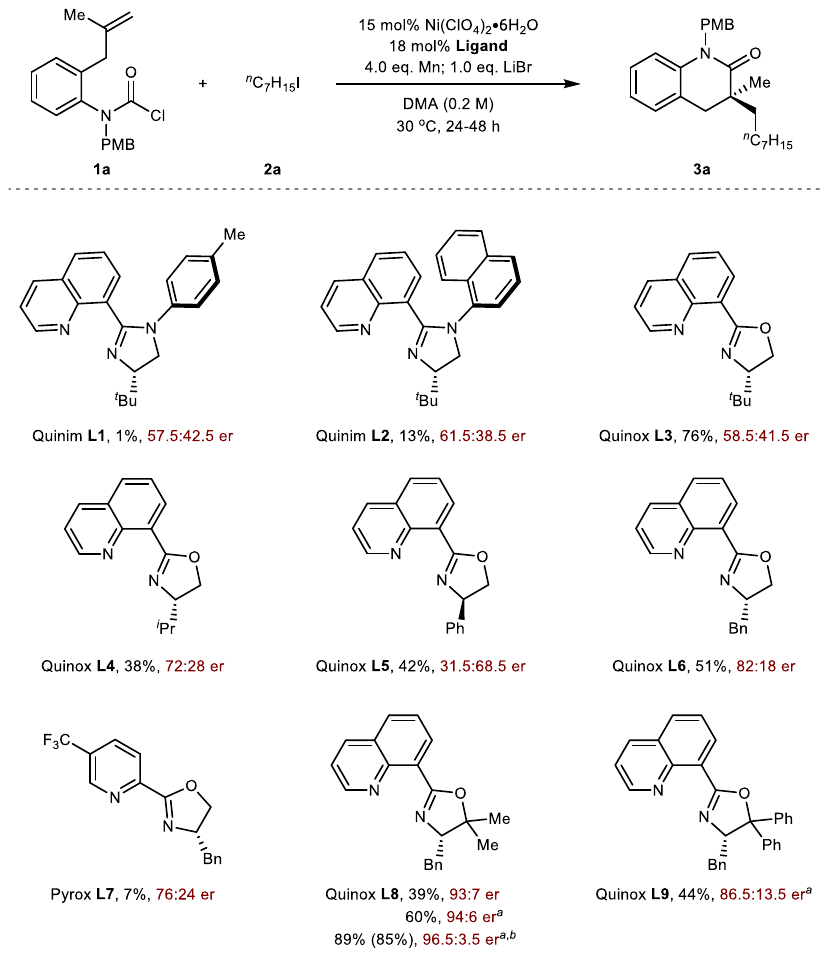
Fig.2|Optimizationofthereactionconditions. Thereactionwasperformedwith carbamoyl chloride 1a (1.0 eq.), iodoheptane 2a (3.0 eq.), Ni(ClO 4 ) 2 (cid:129) 6H 2 O (15mol %),Ligand(18mol%),Mn(4.0eq.),LiBr(1.0eq.),DMA(0.2M),stirredfor24hunder 30°C. The yields were reported as corrected GC yield and the er values were